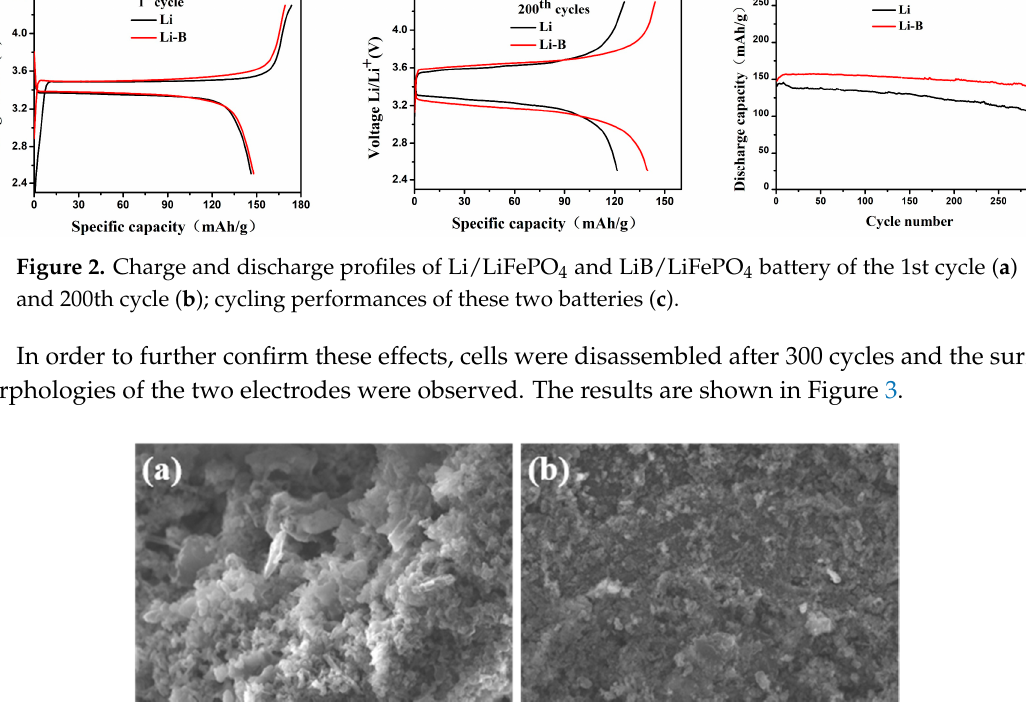
Figure 3. SEM images of the Li metal electrode ( a ) and Li-B alloy electrode ( b ) after 300 cycles.